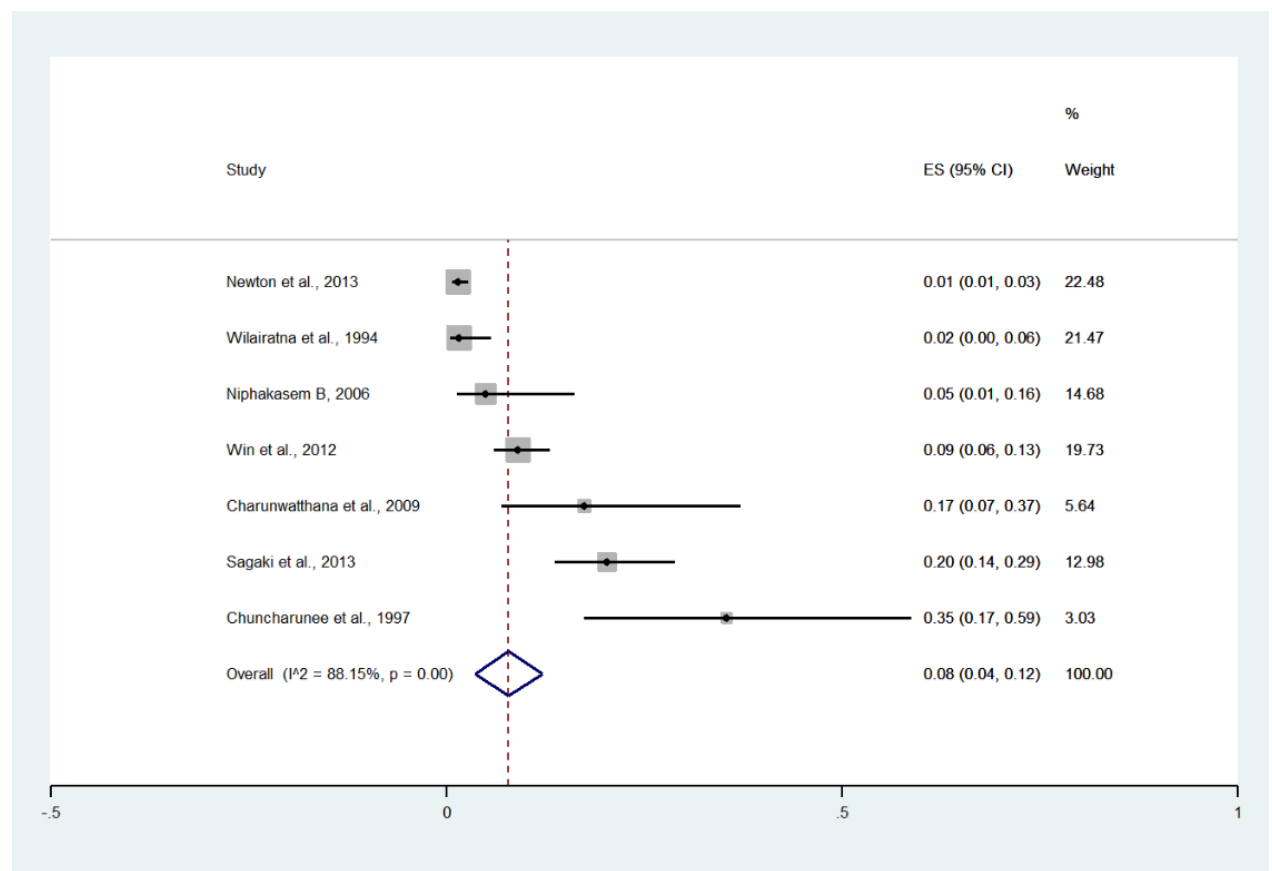
Figure 15. The pooled prevalence of pulmonary edema/ARDS among patients with severe malaria in Thailand. The label for the x-axis is the scale of estimated prevalence. Abbreviations; ES, estimated prevalence; CI, confidence interval. Table 2. The pooled prevalence of each sign of severity among patients with severe malaria in Thailand (total number of patients with severe malaria = 2900).